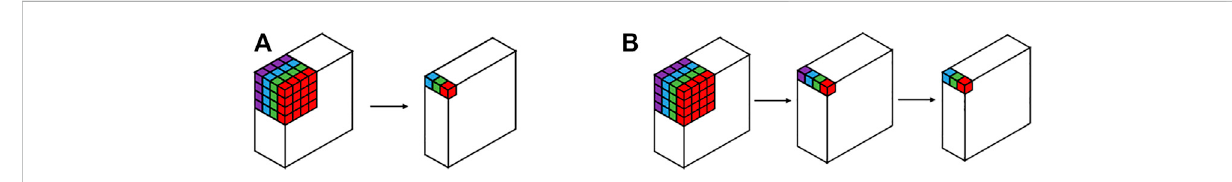
Convolution. (A) Standard convolution; (B) Depth-wise separable